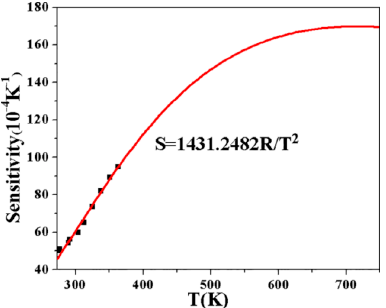
Figure 6. The experimental temperature sensitivity as a function of temperature ranging from 276 to 363 K.